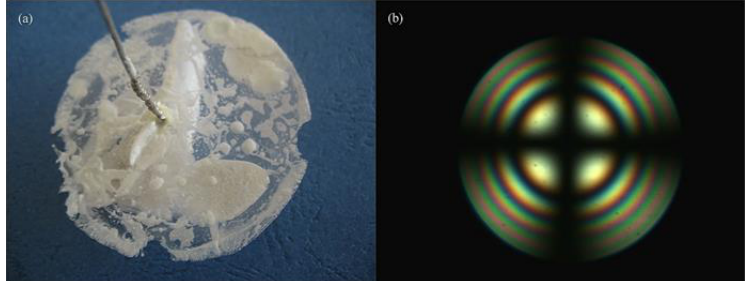
Figure 21. ( a ) The as-grown BaZnBO 3 F crystal; ( b ) Interference pattern of BaZnBO 3 F along the c -axis. Reprinted from Ref. [135], Copyright (2016) with permission from Elsevier.